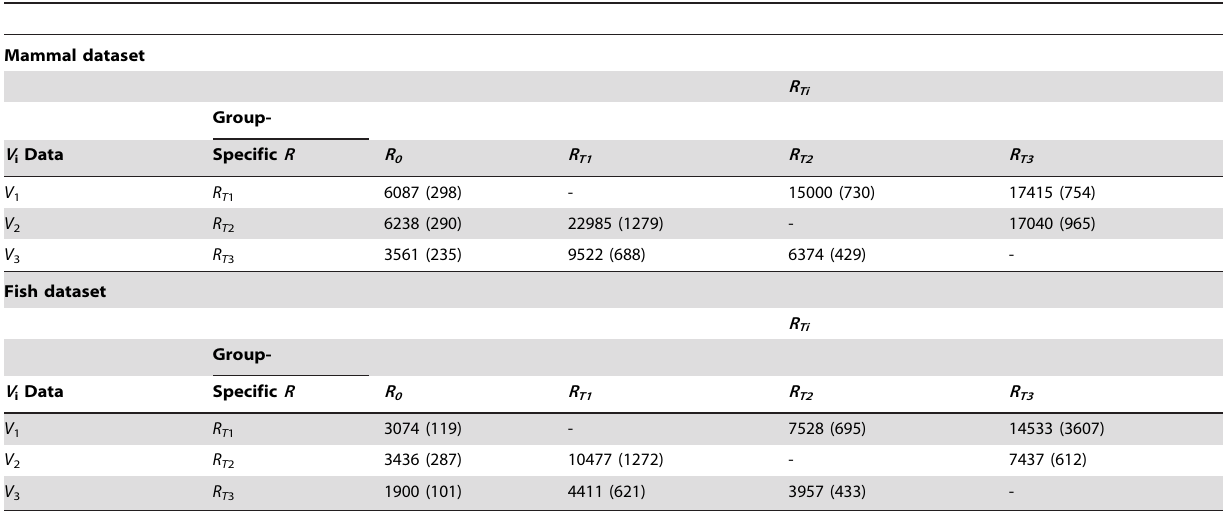
Table 6. Mean and standard deviation (in parentheses) of difference in log-likelihood between group-specific and alternative rate matrices ( R Ti ) as applied to the validation datasets ( V i ) of the cross validation